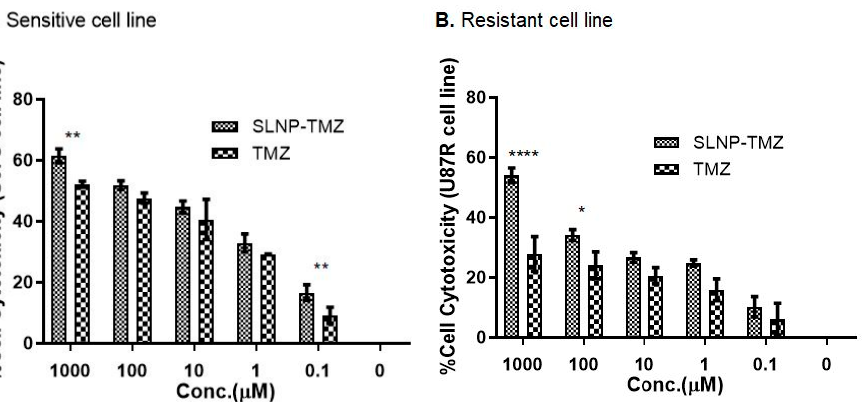
Figure 12. The cytotoxicity assay of TMZ and SLNP-TMZ (0.1–1000 µM) in U87-S ( A ) and U87-R ( B ) following an incubation period of 24 h. Experiments were repeated three times independently, and each assay was performed in triplicate. * p ≤ 0.05, ** p ≤ 0.01, **** p ≤ 0.0001.